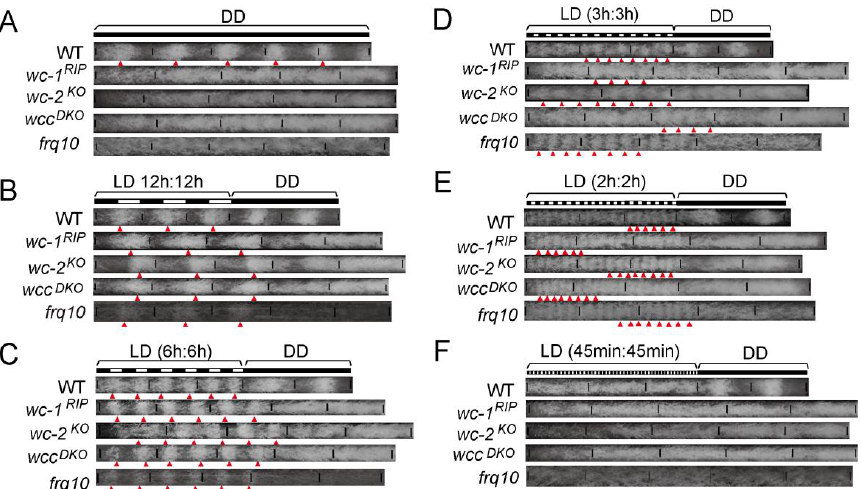
Figure 3. The conidiation rhythms of neurospora strains in short LD cycles. The conditions were DD ( A ), LD12:12 ( B ), LD6:6 ( C ), LD3:3 ( D ), LD2:2 ( E ) and LD45 min:45 min ( F ). Representative results ( n ≥ 3) are shown. Triangles denote the conidiation bands. The strains were grown under white light and the light intensity was 5000